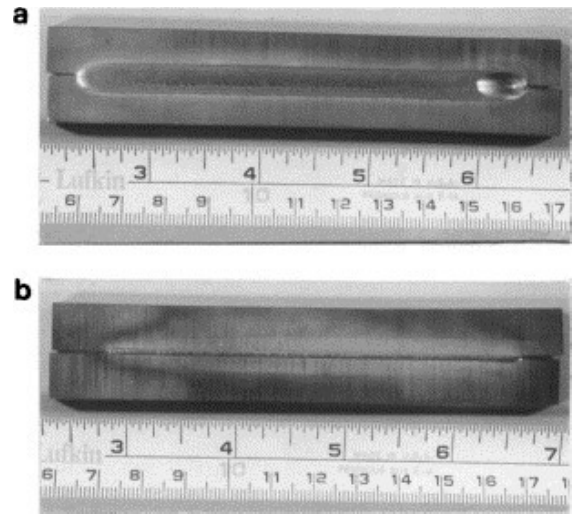
Figure 11. ( a ) Top and ( b ) bottom views of a crack-free weld made at a cooling rate of 240 °C·s −1 . (Reprinted with permission from [107]. Copyright 2001